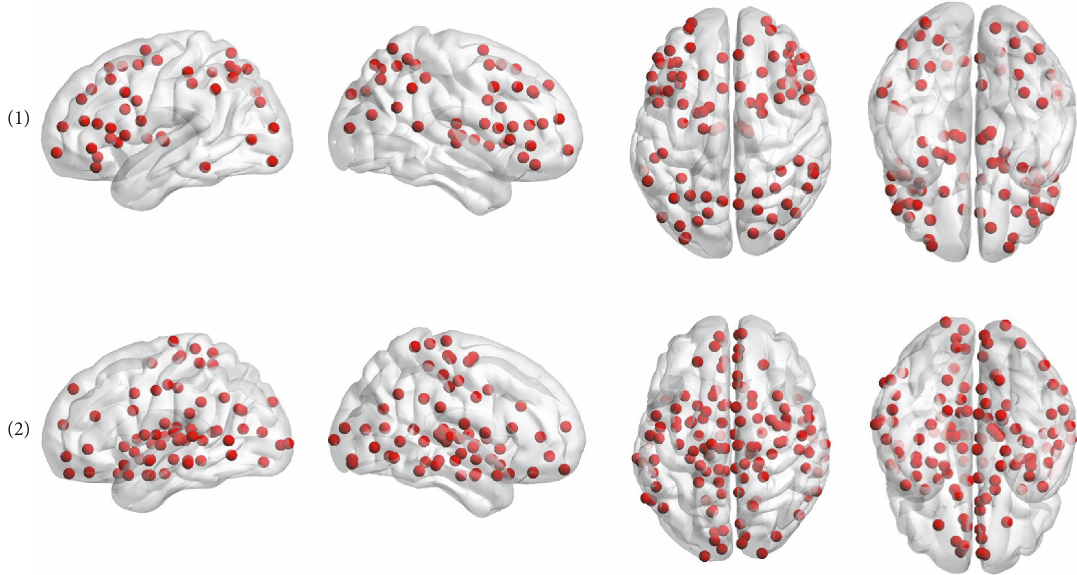
Figure 4: The two group level functional communities detected in Pearson’s networks. In each row, a single community is shown in four brain views (left side, right side, top side, and bottom side).